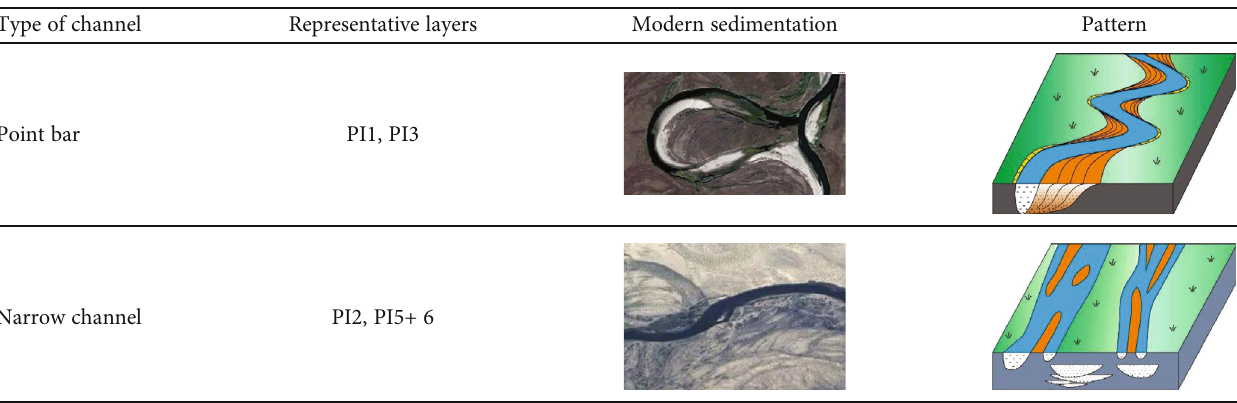
Table 5: Channel sand body